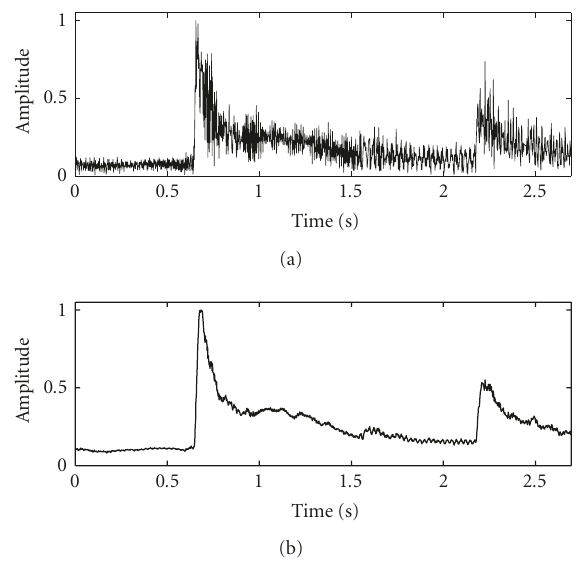
Figure 4: The smoothing e ff ect of the energy integration function emphasizes signal attacks but masks rapid modulations. The image shows a pitched frequency channel corresponding to piano signal (a) before smoothing and (b) after smoothing.